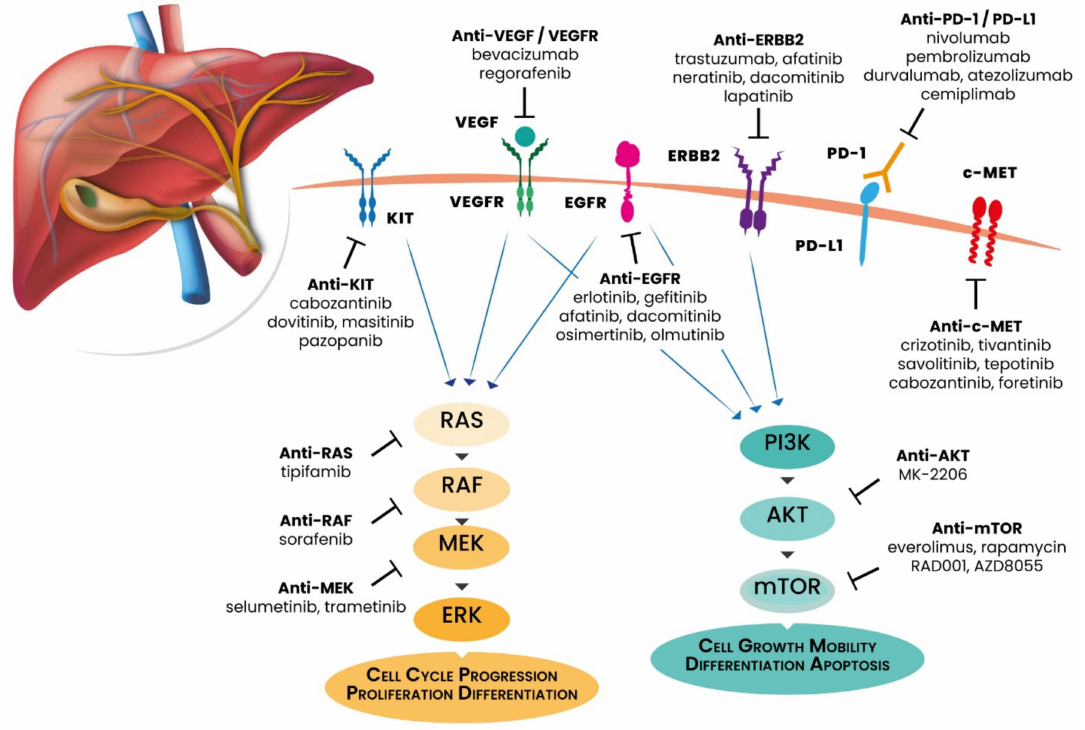
Figure 1. Main actionable gene mutations of gallbladder cancer with relative targeted